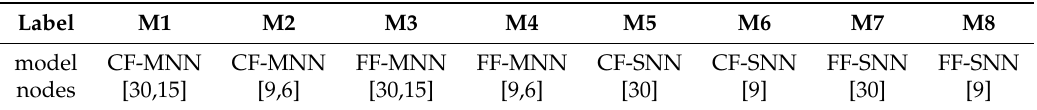
Table 2. The selected